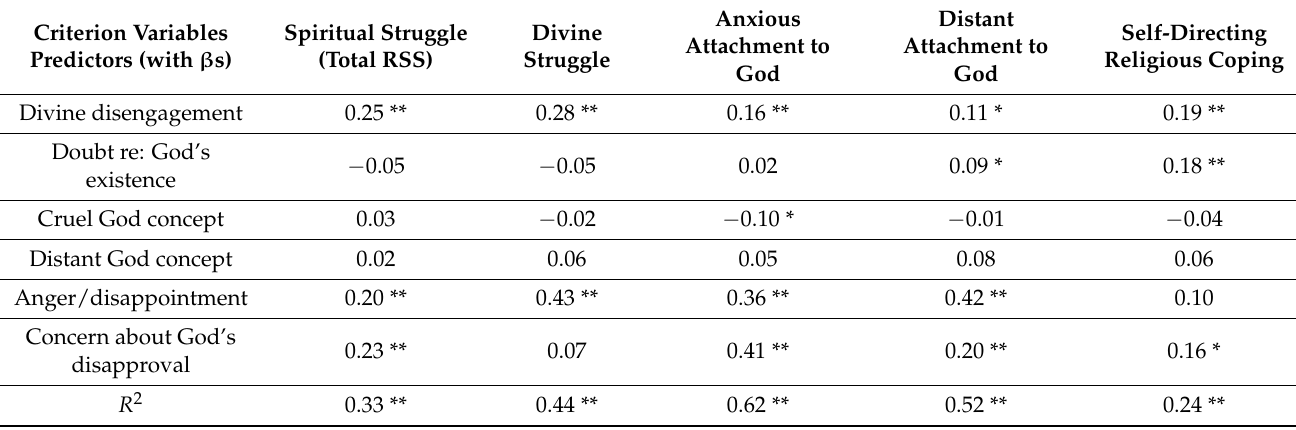
Table 10. Predicting Divine Struggle and Distant Relationships with God from Divine Disengagement and other Indicators of Divine Struggle: Simultaneous